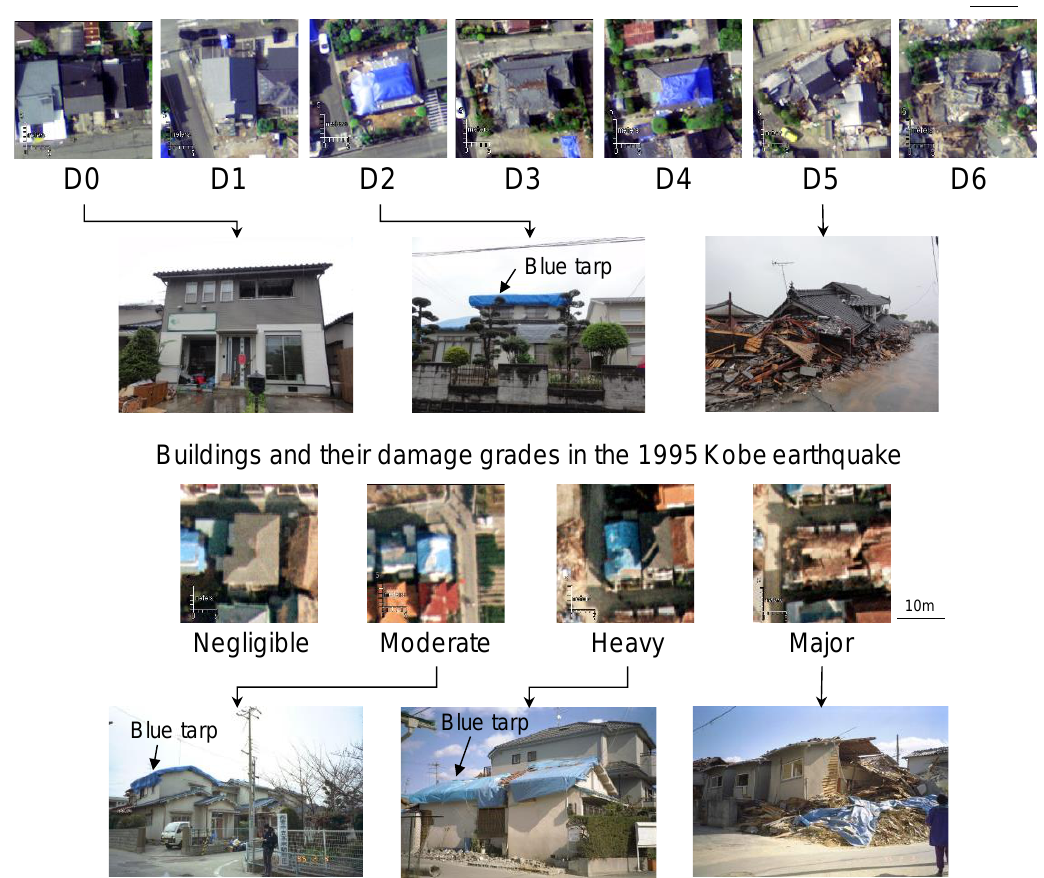
Figure 4. Close-ups of the typical buildings in the aerial images for each damage grade with ground photographs. The ground photographs of the 1995 Kobe earthquake are derived from the Nishinomiya database [36]. Table 3. Damage grades of extracted blue tarp covered buildings.